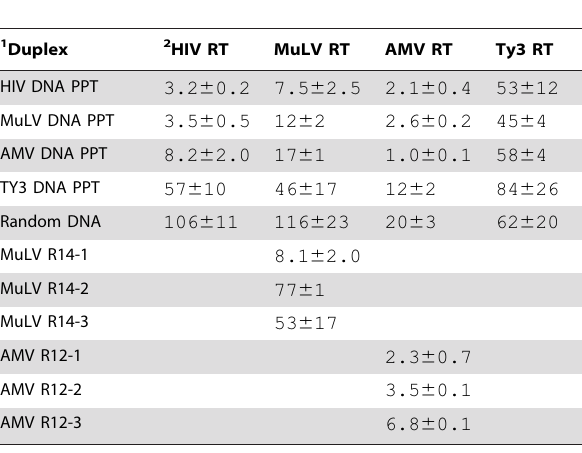
1 Refer to Fig. 1 for duplex sequences. 2 Experiments for determining K d values are illustrated in Fig. 2. All values are an average of 2–4 independent experiments 6 standard deviations. Values are in nM and were calculated based on protein mass as provided by the manufacturer (HIV, MuLV, and AMV RTs) or determined as described (Ty3) [31]. Active site concentrations were not